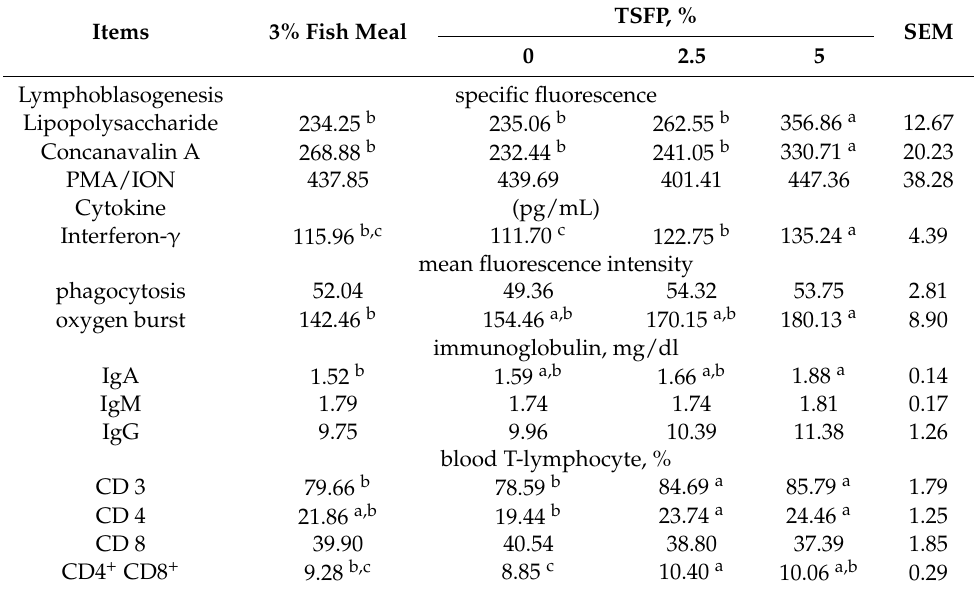
Table 7. Effect of TSFP on the immunity of finishing